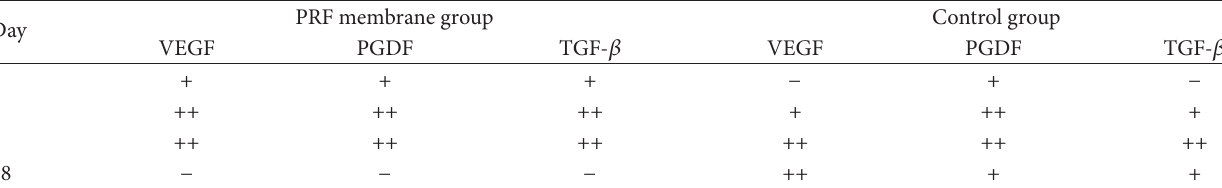
Table 2: The comparison of the immunohistochemical